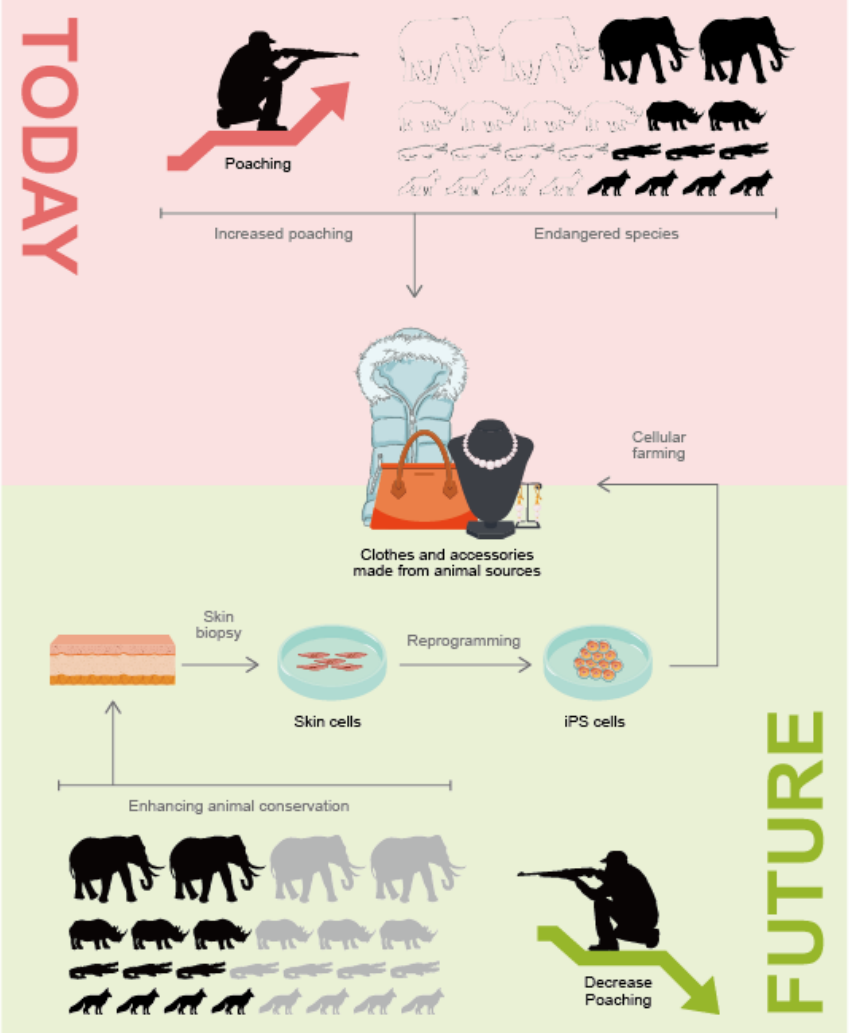
Figure 2. The use of iPSC technology for the production of exotic animal products could decrease animal poaching.